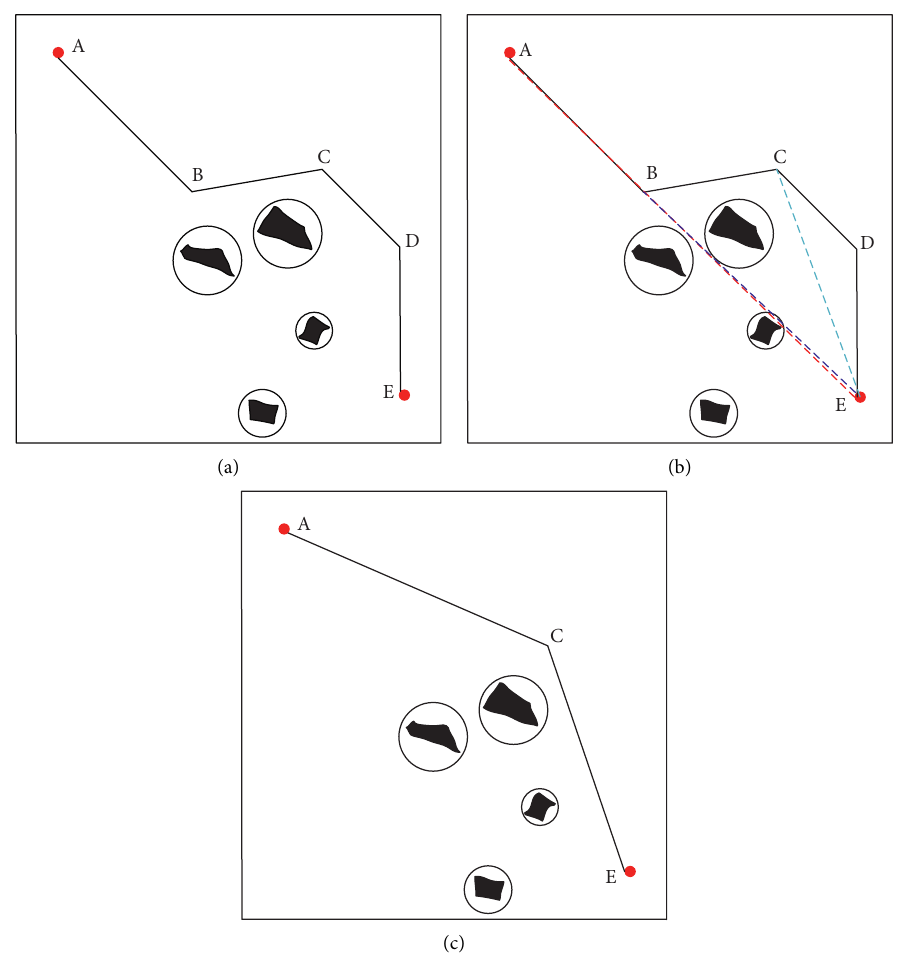
Figure 6: Improved DP algorithm idea diagram. (a) Path optimized by DP algorithm. (b) Optimization thinking chart of point E. (c) Improved DP algorithm optimized